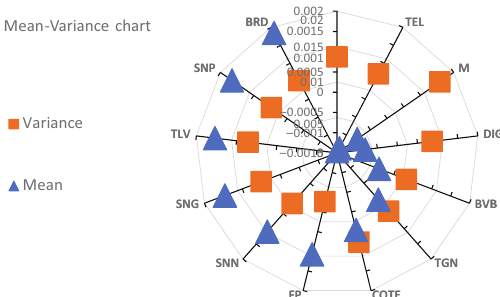
Figure 3. Mean – Variance chart for BET companies (source of data: Bucharest Stock Exchange (BSE); source: own processing based on the data available on Betfair,